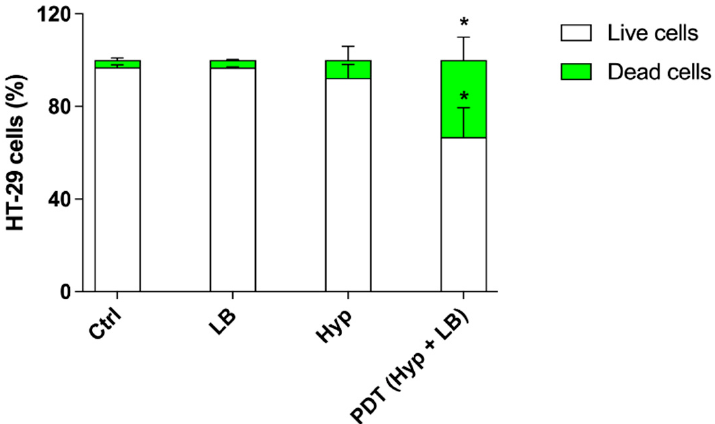
Figure 11. Effects of Hyp-mediated photodynamic treatment on HT-29 spheroids. ( a ) Representative optical (bright field) and fluorescence (PI staining in red) images that were acquired 48 h after the spheroid treatment as follows: untreated spheroid, spheroid incubated with 0.2 µ M Hyp, spheroid exposed to LB (green led at 1.5 W/cm 2 for 20 min), and spheroid treated with PDT (0.2 µ M Hyp + LB). Magnification 10 × , scale bar: 100 µ m. ( b ) Quantification of PI fluorescence intensity in HT-29 spheroids after the different treatments. Statistically significant difference of treated cells versus untreated cells: * p ≤ 0.05 ( n = 3).